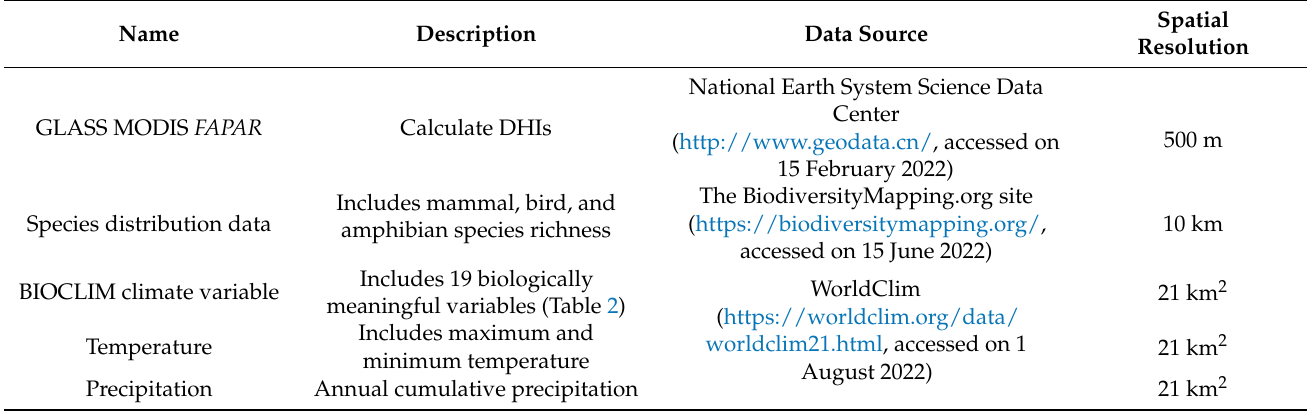
Table 1. Datasets used in this study.